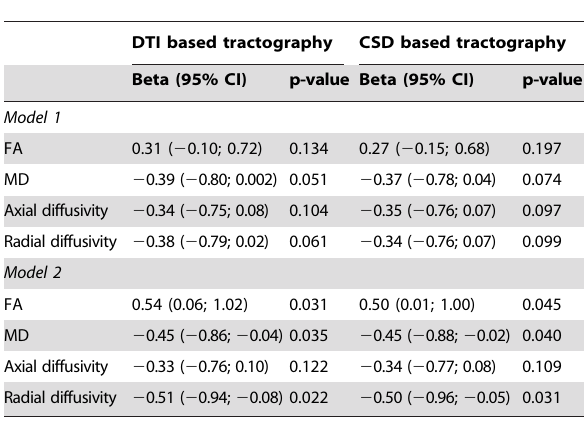
Tabel 2. Association diffusion parameters of the CC and memory performance.